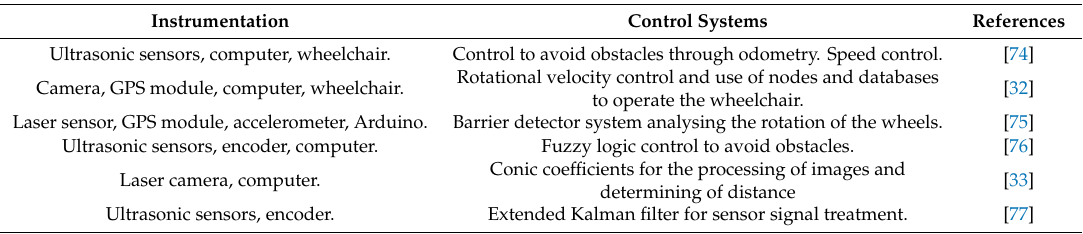
Table 8. Instrumentation and control strategies for obstacle